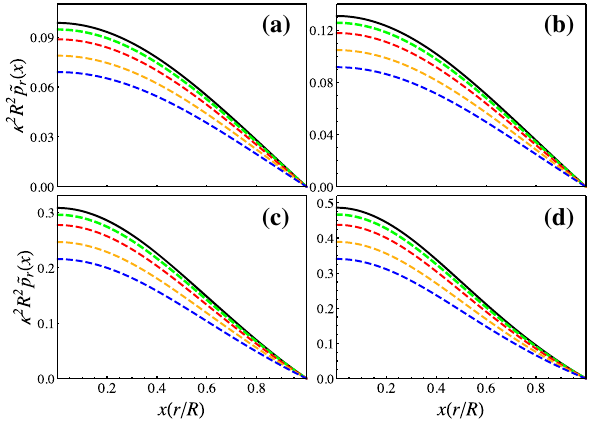
Fig. 2 Effective radial pressure ˜ p r . For a u = 0 . 13, b u = 0 . 15478, c u = 0 . 2035, d u = 0 . 229365. α = 0 (black solid line), α = 0 . 04, (green dashed line), α = 0 . 1 (red dashed line), α = 0 . 2 (yellow dashed line), α = 0 . 3 (blue dashed